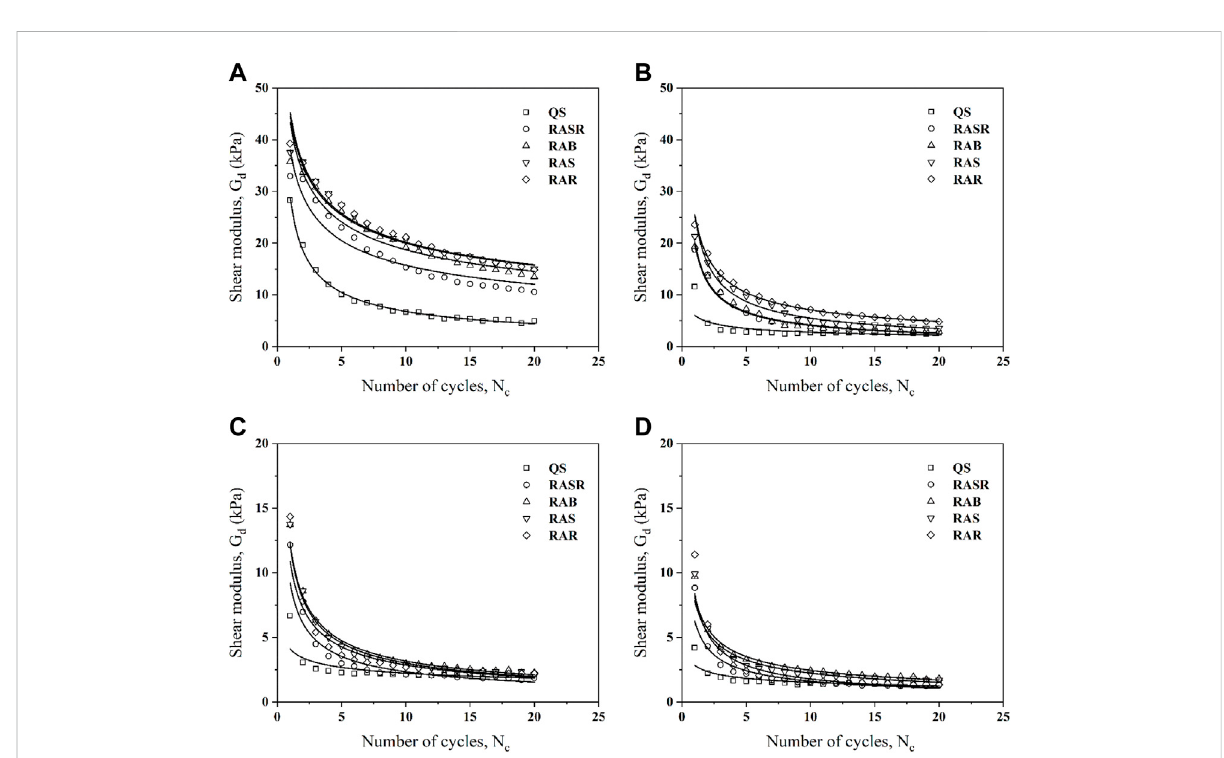
FIGURE 12 In fl uence of the particle regularity on the dynamic shear modulus under different shear strain amplitudes: (A) A γ = 0.1%; (B) A γ = 0.2%; (C) A γ = 0.3%; (D) A γ =